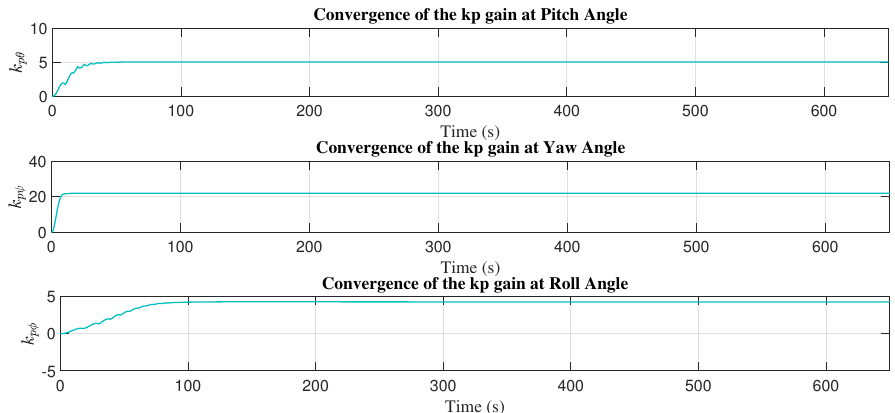
Figure 24. Minimization of J θ , ψ , φ with MIT rule with high order sliding modes (MIT-HOSM).